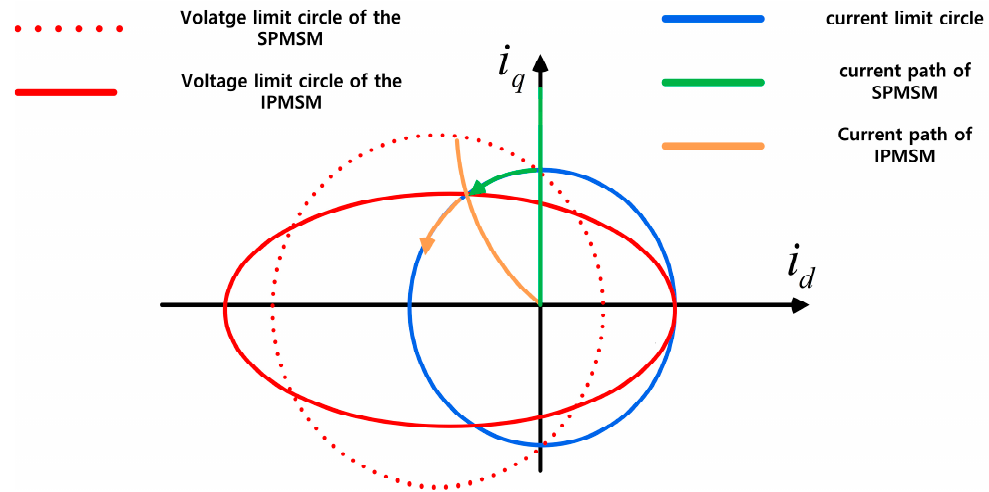
Figure 3. Voltage and current limit circle of the SPMSM and IPMSM.